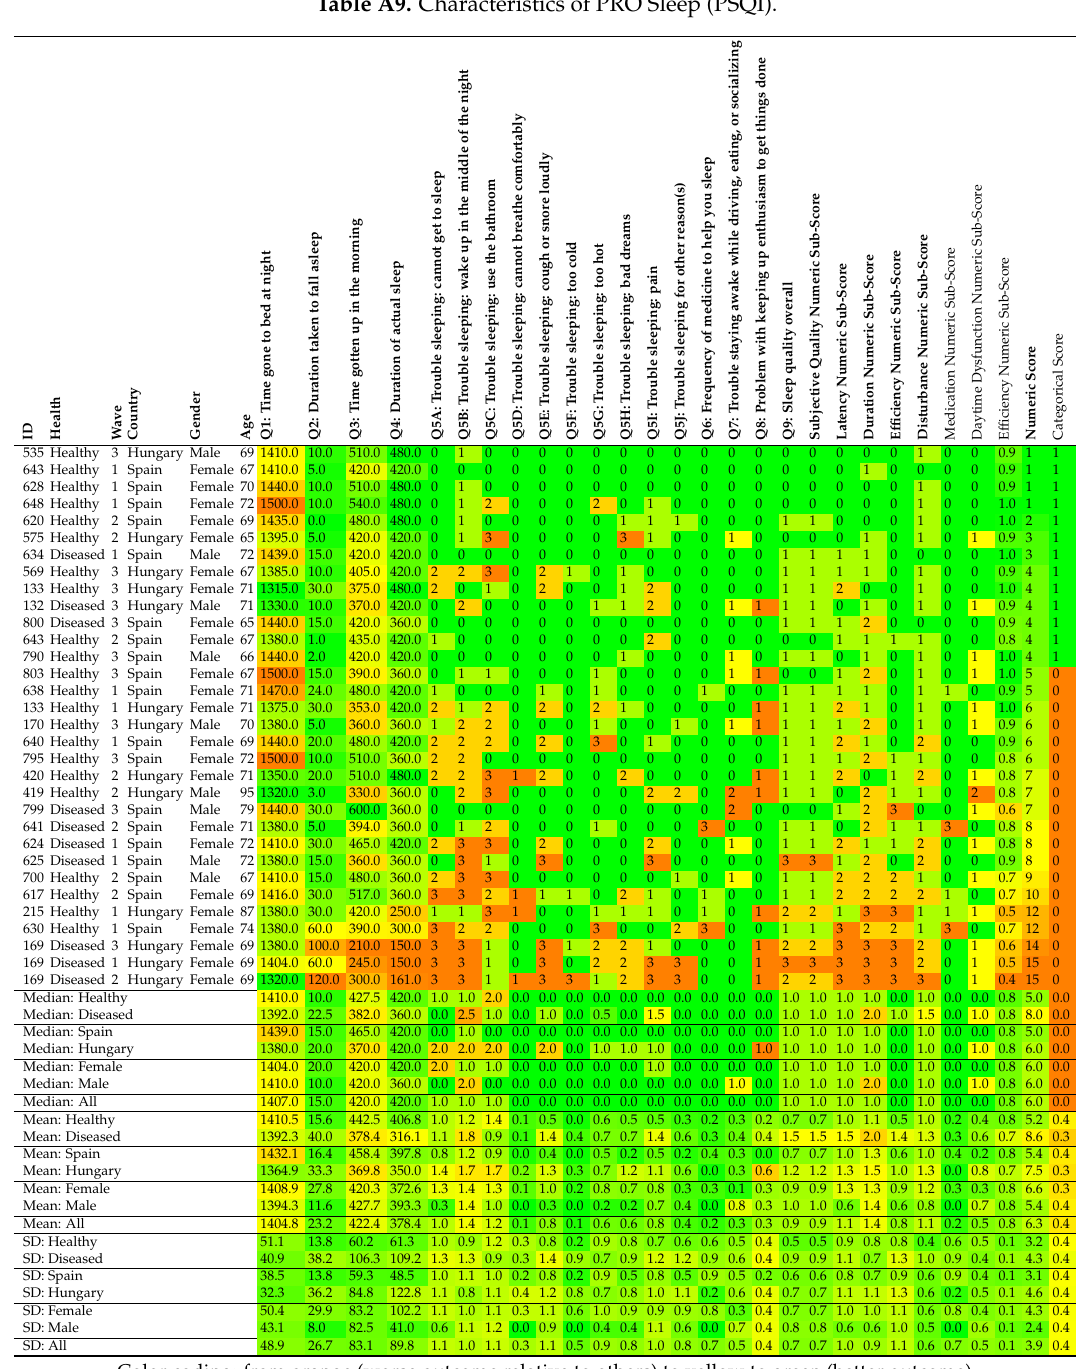
Table A9. Characteristics of PRO Sleep (PSQI).